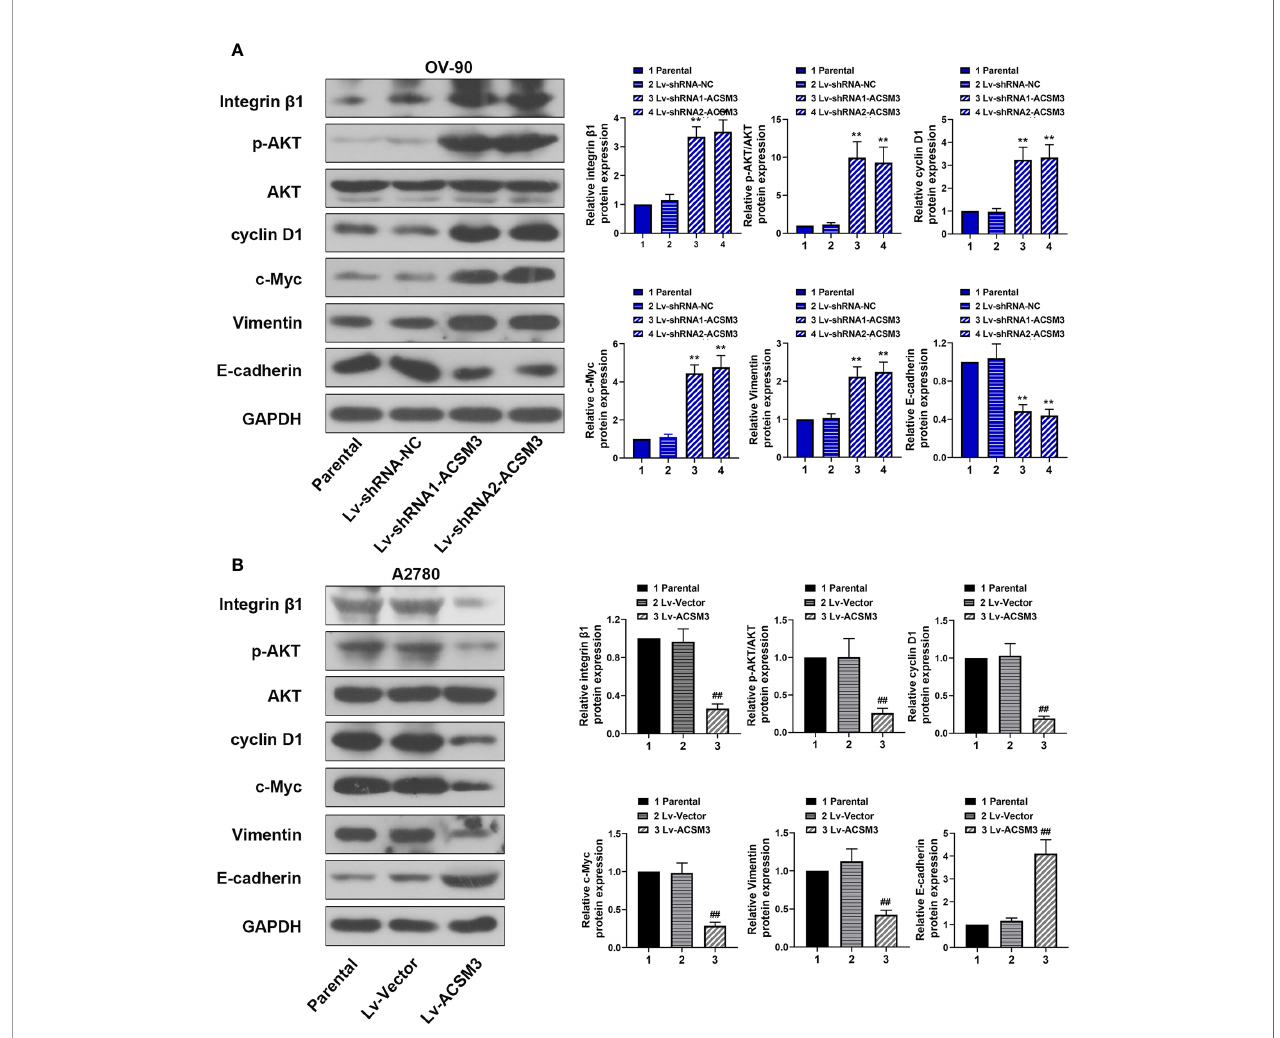
FIGURE 4 | Effects of ACSM3 on the Integrin b 1/AKT signaling pathway in ovarian cancer. (A) The protein expression of Integrin b 1, p-AKT, AKT, cyclin D1, c-Myc, Vimentin, and E-cadherin in OV-90 cells following ACSM3 knockdown. (B) The protein expression of Integrin b 1, p-AKT, AKT, cyclin D1, c-Myc, Vimentin, and E- cadherin in A2780 cells following ACSM3 overexpression. Measurement data were expressed as mean ± SD of three independent experiments. **P < 0.01 versus Lv-shRNA-NC; ## P < 0.01 versus